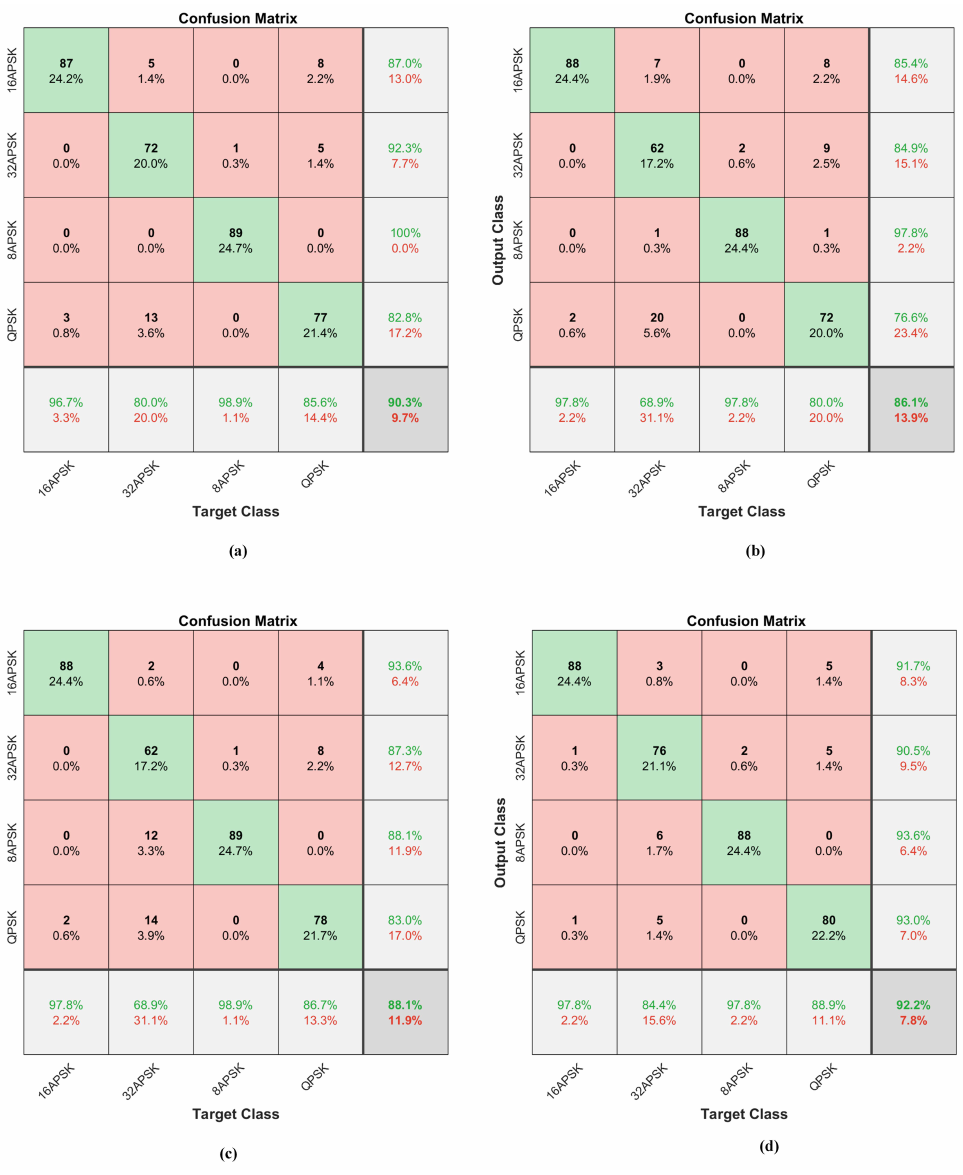
Figure 7. AMC results in the presence of CWI (AMC2) using ( a ) AlexNet (90.30%), ( b ) VGG16 (86.1%), ( c ) GoogleNet (88.1%) and ( d ) ResNet18